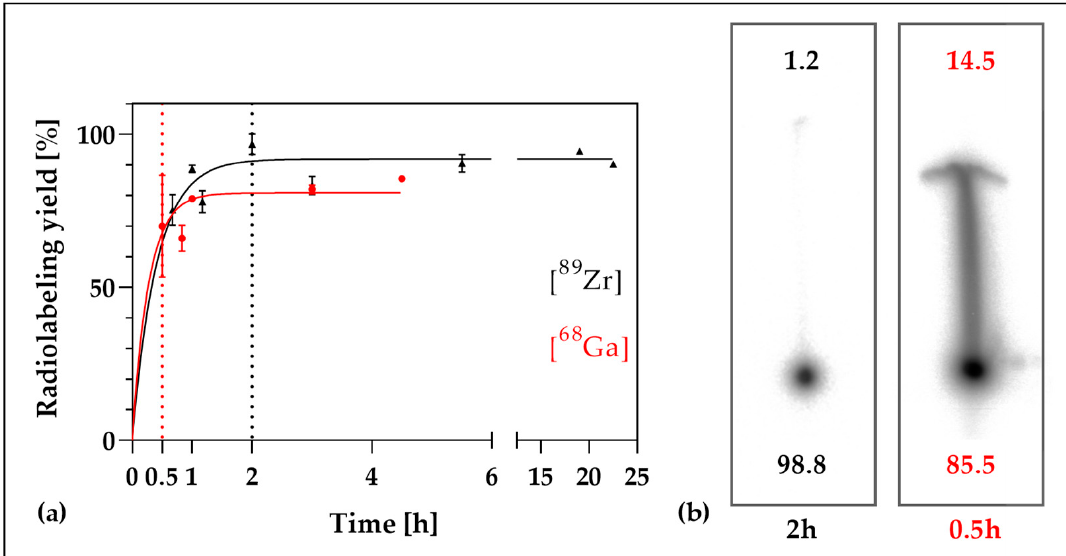
Figure 1. Radiolabeling of the nanodiamonds. 89 Zr- and 68 Ga-labeling diagram of bound activity in terms of time, followed for 4.5 h ( 68 Ga) and 24 h ( 89 Zr), respectively ( a ). For zirconium-89 already after 2 h of incubation (97 ± 3)% of the radioactivity was bound to the nanodiamonds ( a ) as observed by thin layer autoradiography. In the exemplary TLC the relative proportion of bound and free zirconium-89 or gallium-68 is given in percent ( b ).